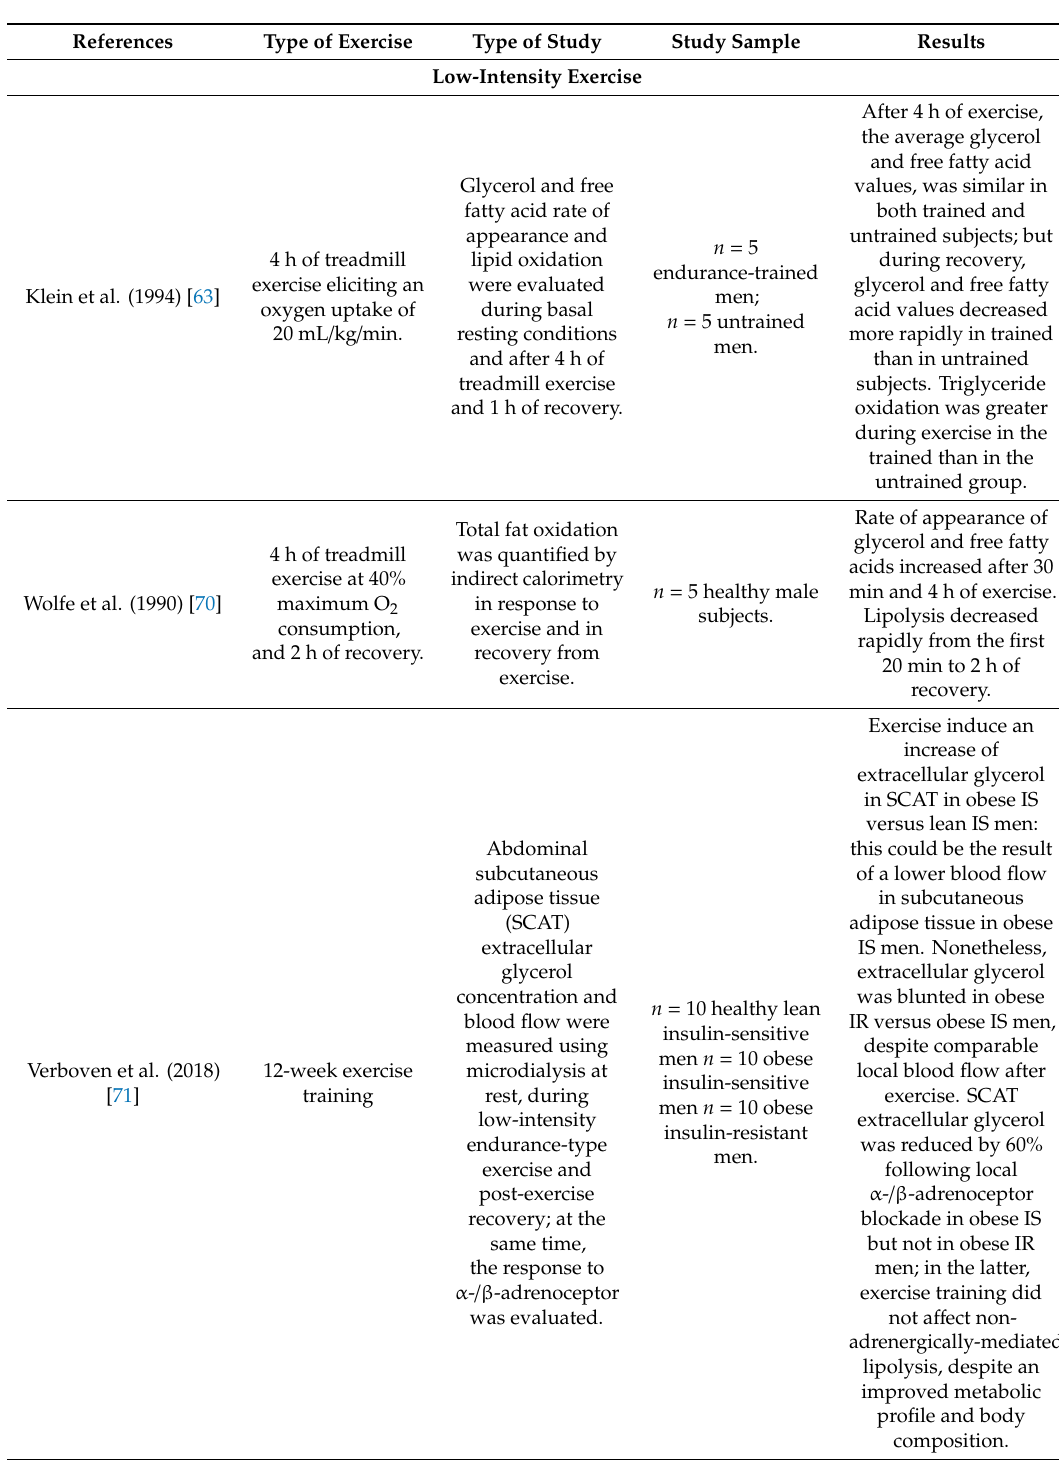
Table 1. Articles included in the